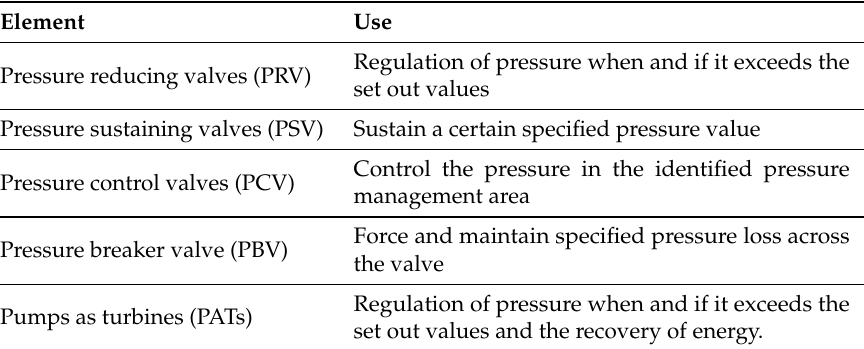
Table 2. Pressure control